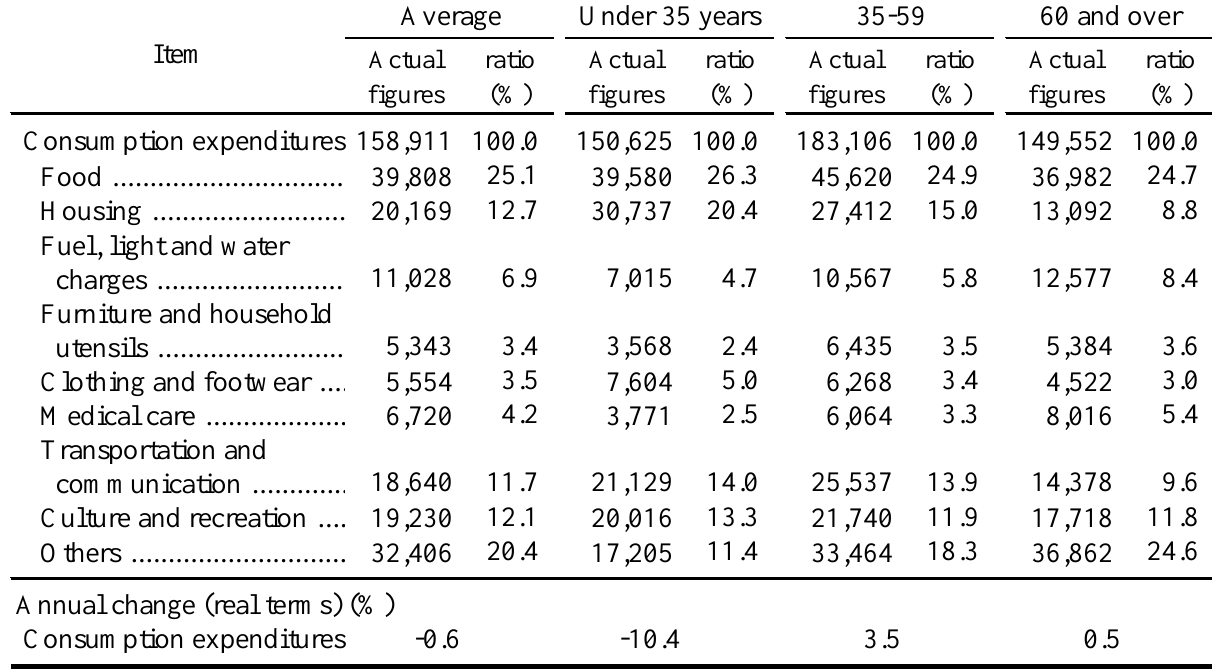
Table 13.2 Average Monthly Consumption Expenditures by Age Group (One-person